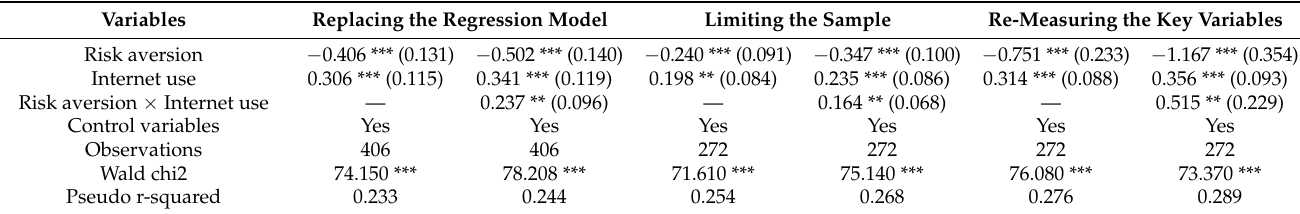
Table 6. Robustness test